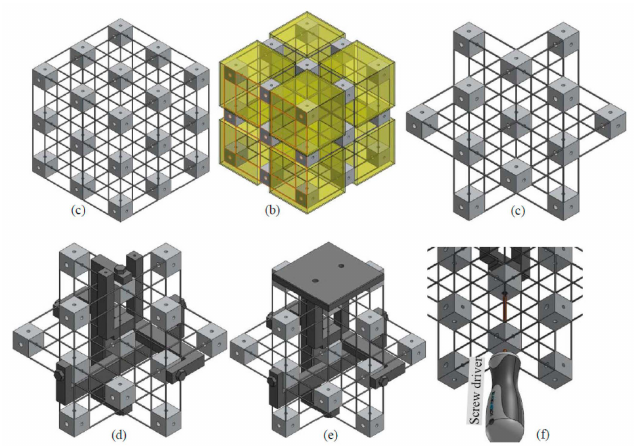
Figure 15. Manufacture and assembling process of the practical design-II: ( a ) monolithically fabricated model, ( b ) demonstration of the vertex cubes, ( c ) monolithically fabricated model without the vertex cubes, ( d ) output platform linkage and rigid cube linkage assembly, ( e ) output platform assembly and ( f ) demonstration of using a screwdriver to assemble the output platform